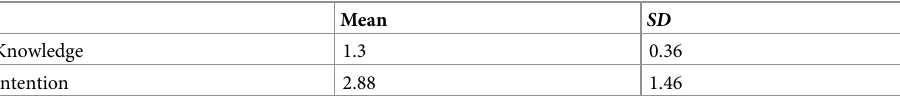
Table 2. Knowledge and intentions